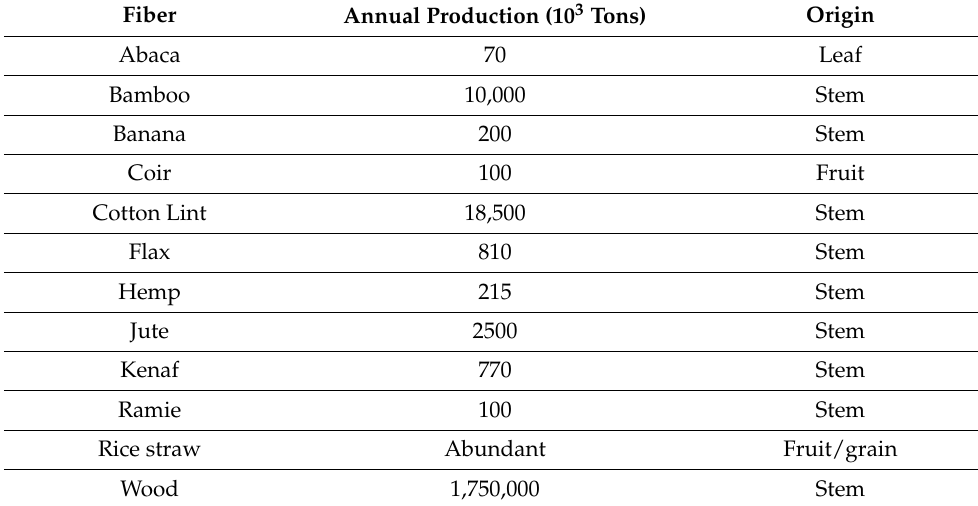
Table 2. Natural fibers production [43,44].